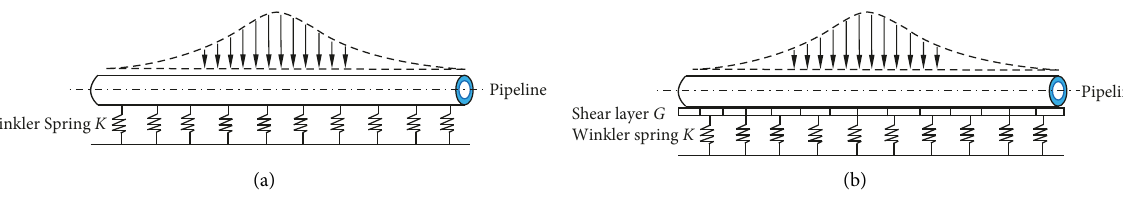
Figure 4: Two different foundation models. (a) Winkler foundation model. (b) Pasternak foundation